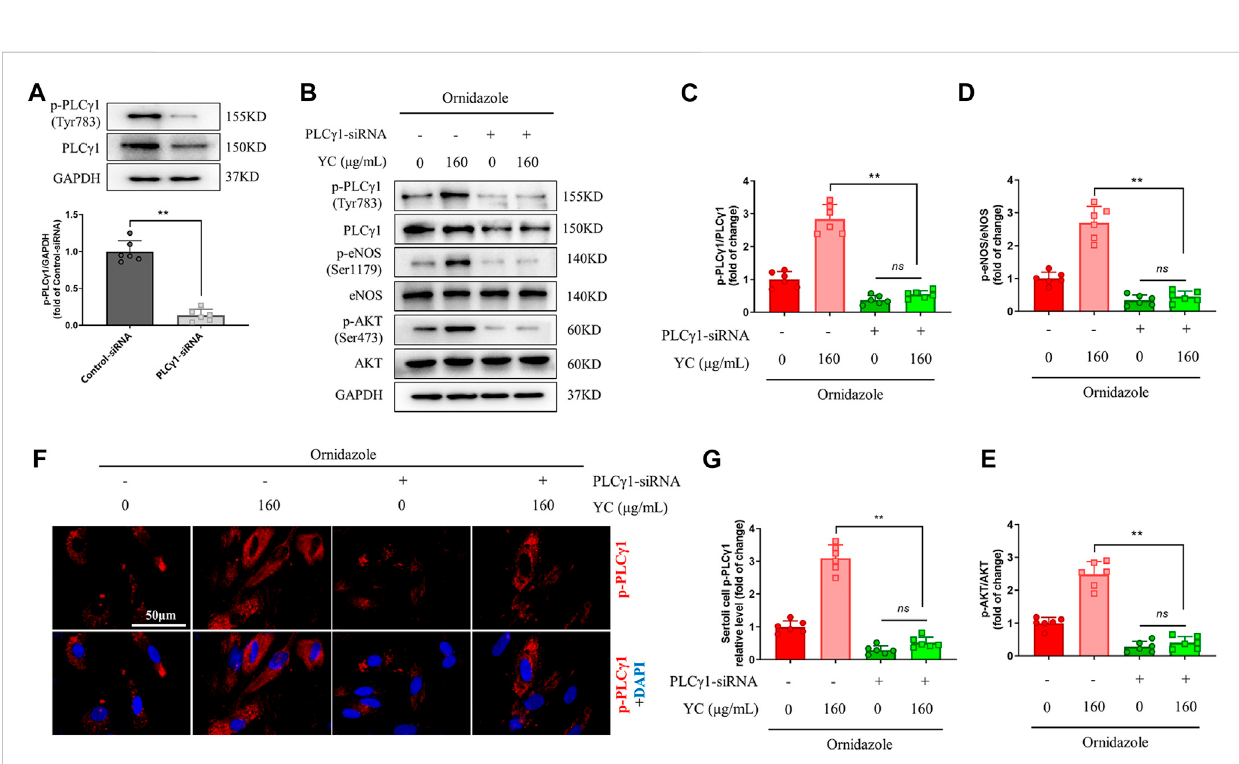
FIGURE 7 PLC γ 1-siRNA compromises YC-induced improvement in primary Sertoli cells exposed to ornidazole. (A) PLC γ 1-siRNA transfection ef fi ciency was measured using the western blot assay. (B – E) Protein expression of p-PLC γ 1, p-eNOS and p-AKT in the western blot analysis. (F, G) Representative images and quanti fi cation of p-PLC γ 1 levels in the immuno fl uorescence assay. Values are shown as averages ± SD ( n = 6). ** p < 0.01; ns, not signi fi cant.